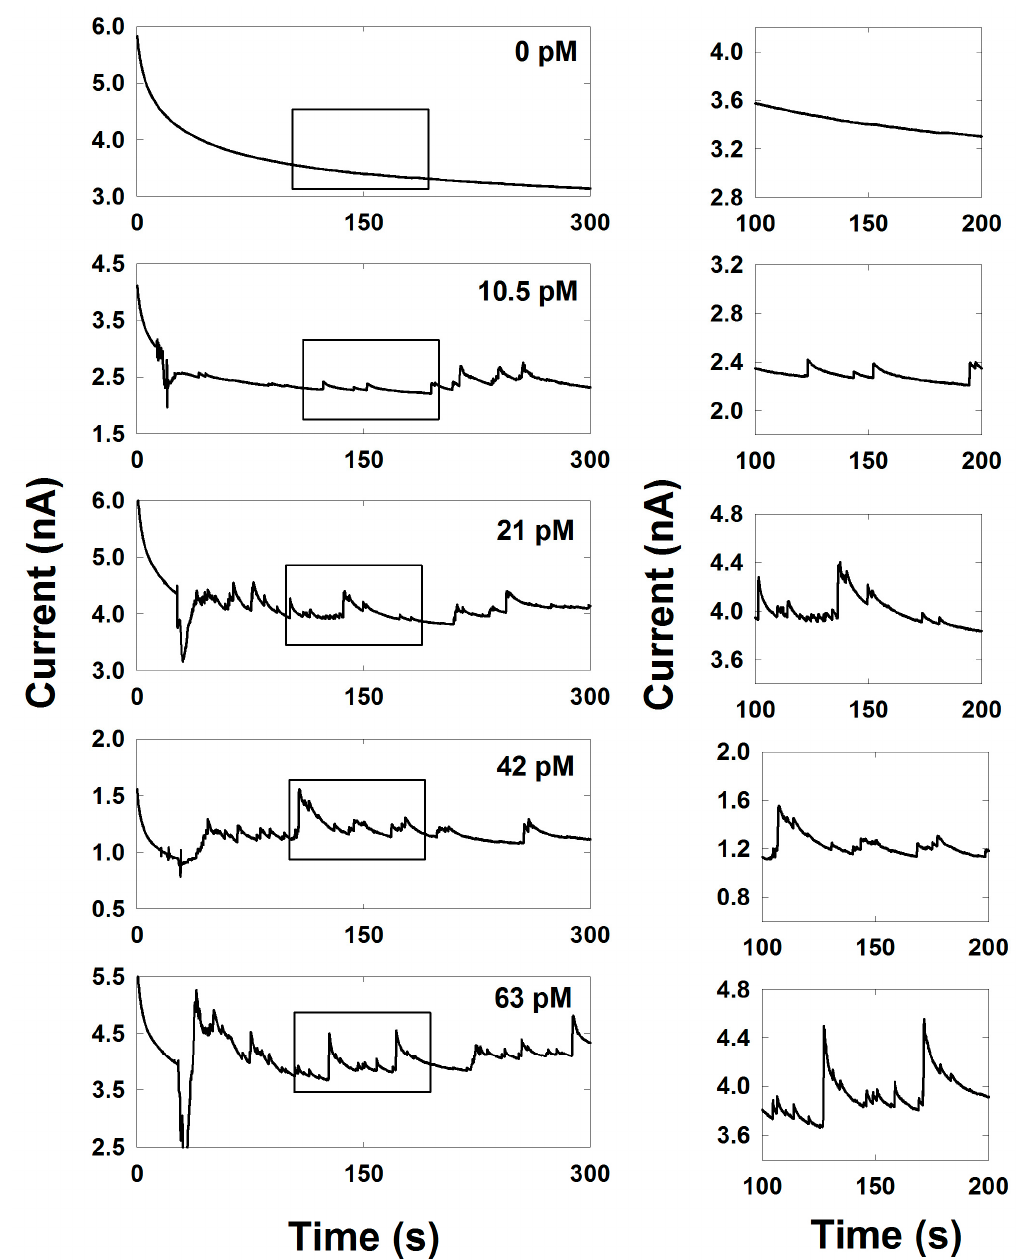
Figure 3. Chronoamperometric curves for single Pd NP collisions at an applied potential of − 0.15 V at the Au UME with different Pd NP concentrations (0, 10.5, 21, 42, and 63 pM) in a 0.1 M PB solution containing 20 mM H 2 O 2 . The data acquisition time was 50 ms.